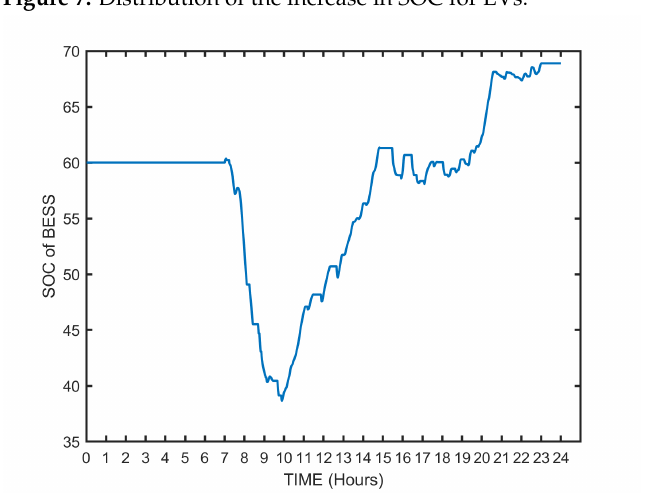
Figure 8. The SOC of BESS for one day of operation.